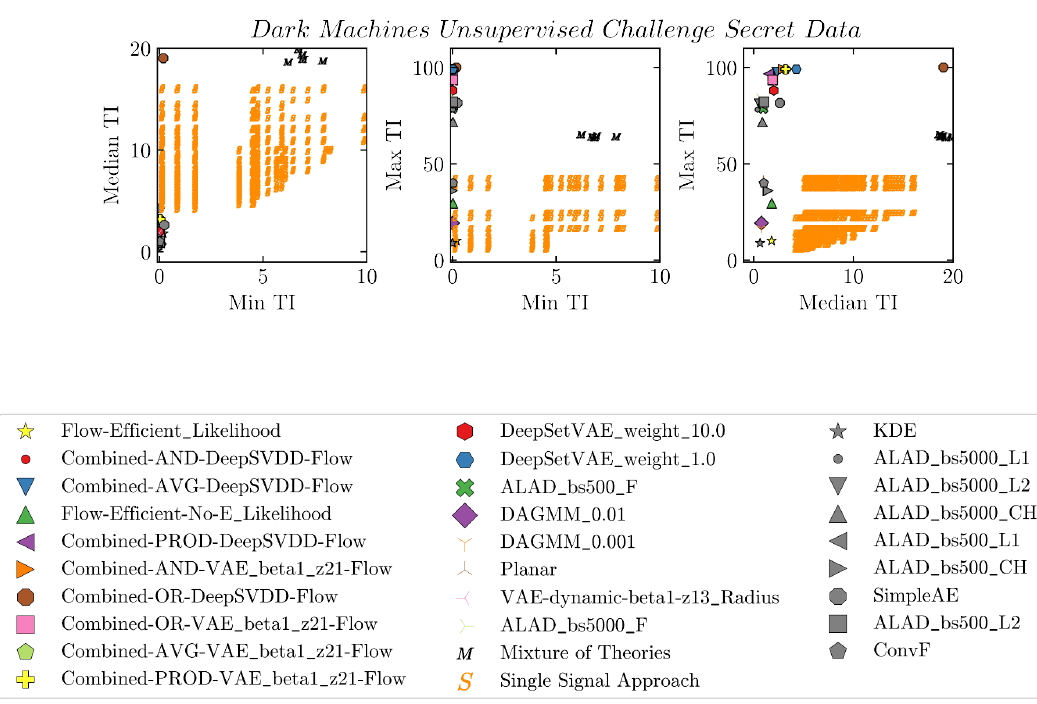
Figure 4 . The figure shows the results for the total improvements of the secret data comparing the supervised and unsupervised methods. There are a total of 2401 SSA models denoted as S , and 5 MoT models trained on all signals denoted as M